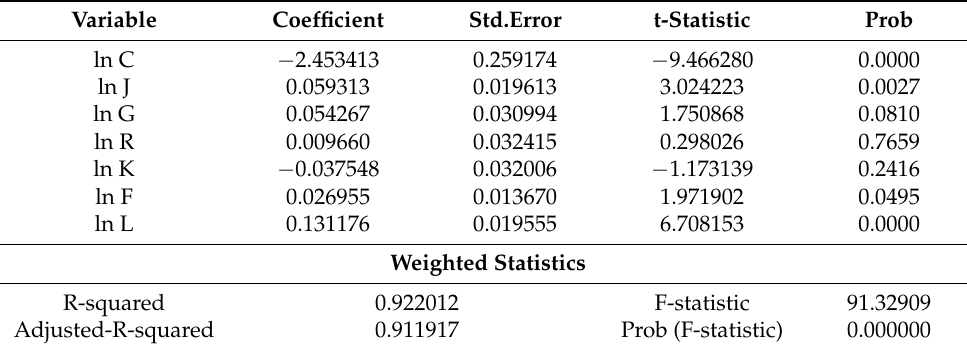
Table 6. The results of model